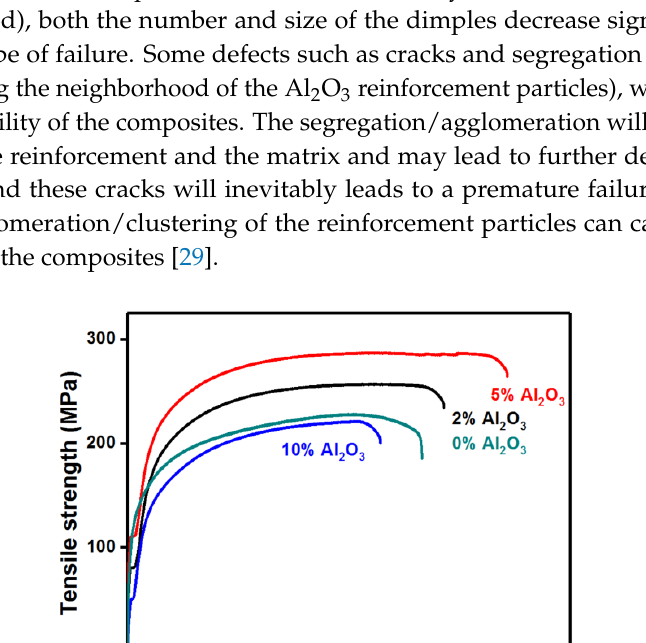
Figure 4. Vickers hardness measurements of Al-12Si/Al 2 O 3 nanocomposites produced by the hot extrusion method.